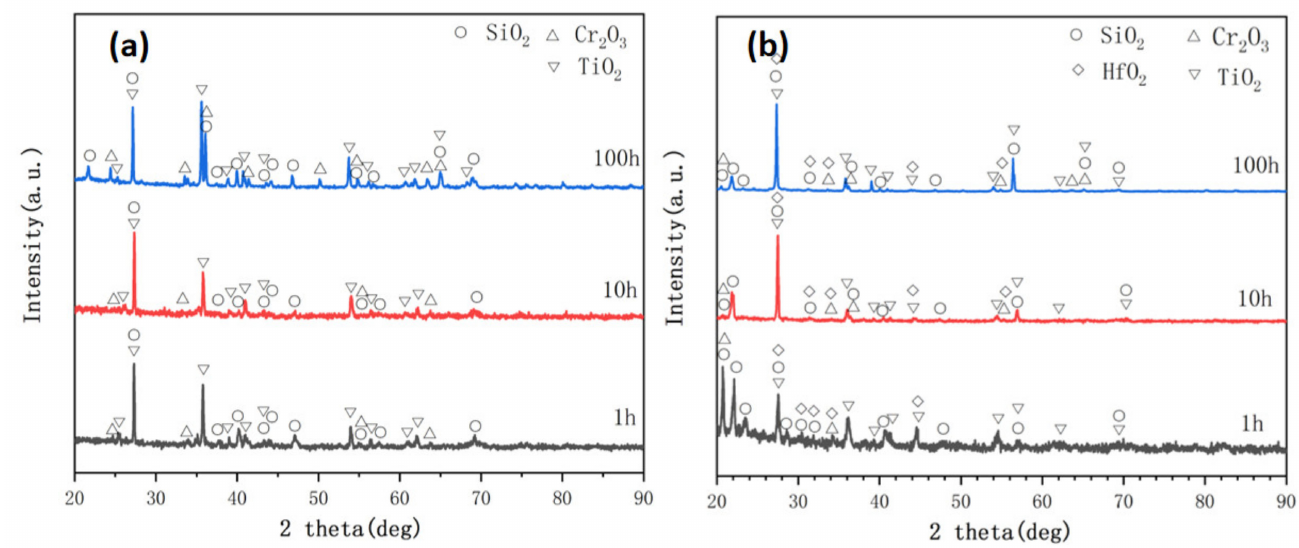
Figure 5. X-ray patterns of B modified silicides coatings prepared with Al 2 O 3 ( a ) and SiO 2 ( b ) after oxidation at 1250 ◦ C.